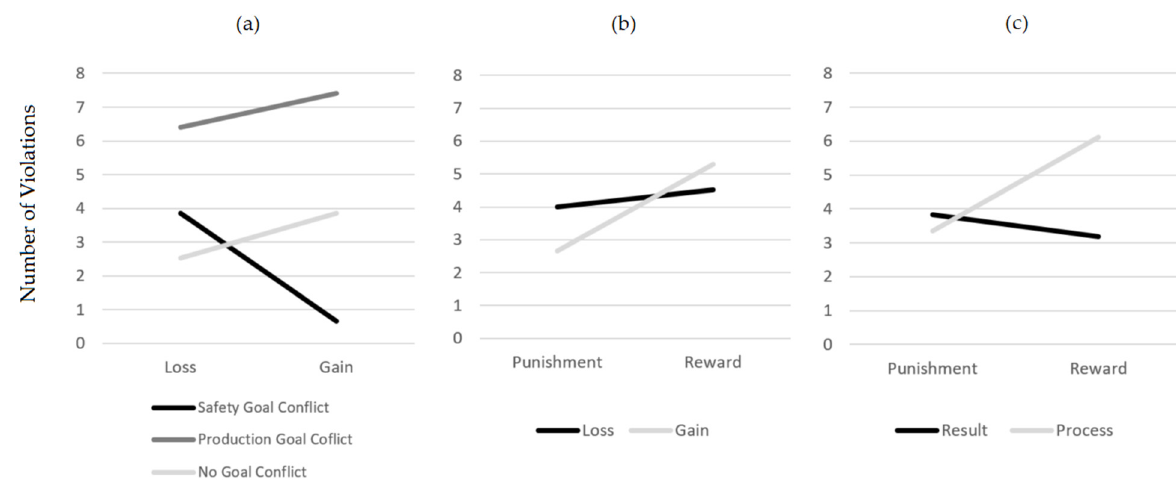
Figure 3. Frequencies of rule violations, broken down between the factors of significant interaction effects; ( a ) Interaction between framing and goals, ( b ) interaction between, consequence and framing; ( c ) interaction between consequence and feedback.